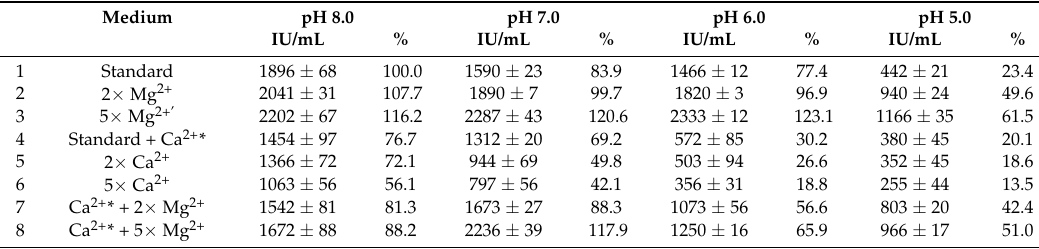
Table 2. Influence of Mg 2+ and Ca 2+ on XI activity at different pHs (isomerization of fructose 2M, as